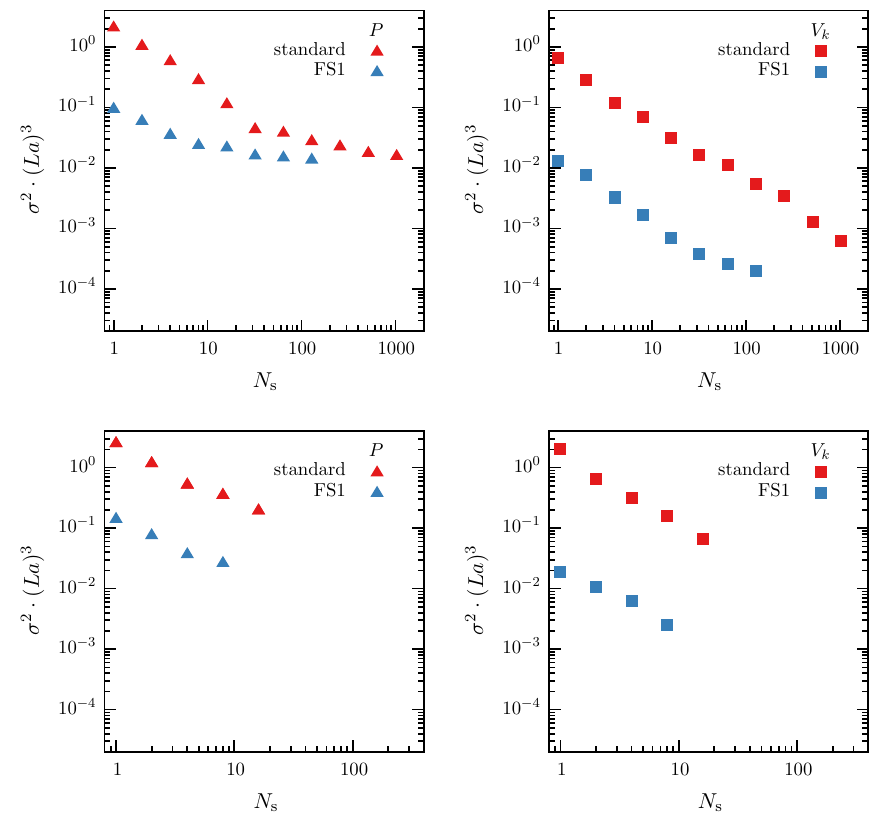
Fig. 10 The figures analogous to Fig. 5 comparing the variances of the standard (red) and frequency-splitting (blue) estimators in the pseudoscalar (left) and vector (right) channels for ensemble E5 (top) and G8 (bottom)